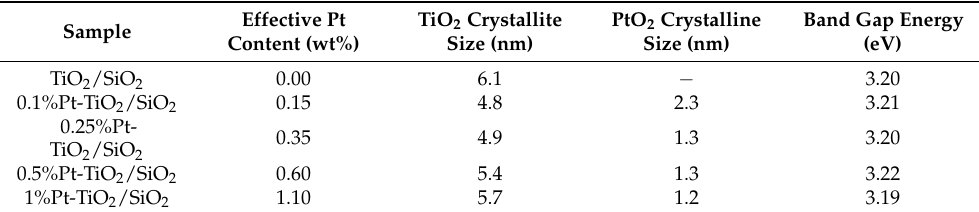
Table 1. Theoretical and effective Pt contents, TiO 2 (anatase) crystallite size, and band gap energy of the prepared photocatalysts with different Pt-doping